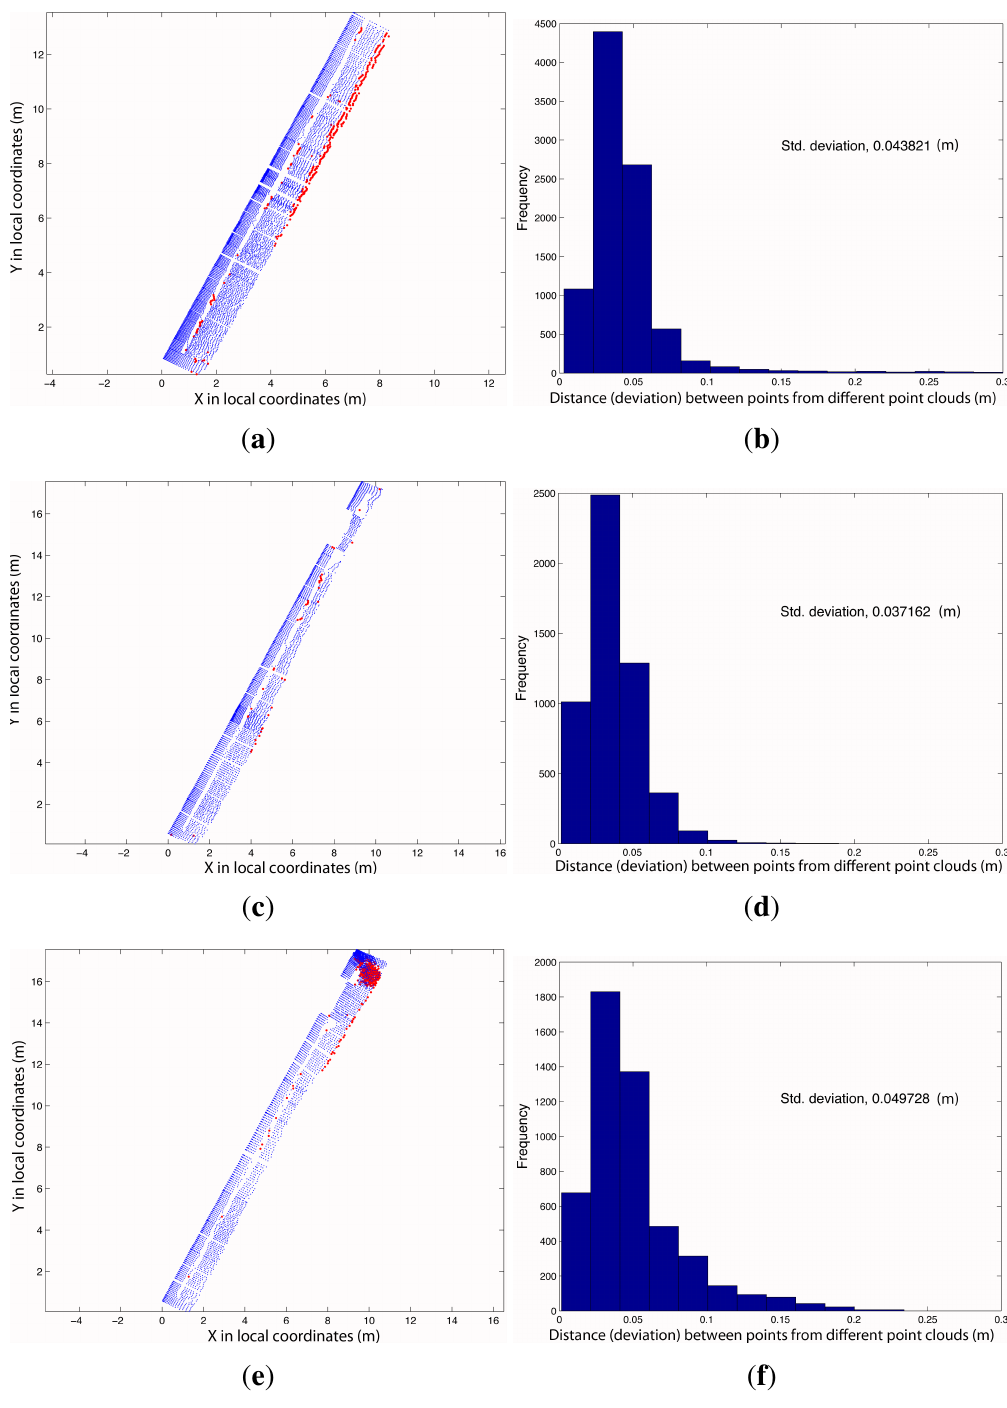
Figure 11. Comparison between four different point clouds produced by four different paths. Red points represent points with errors up to 10 cm. ( a ) Point Cloud 1, where points with errors greater than 0.10 m are represented in red; ( b ) histogram of distances (deviations) between point Clouds 1 and 2; ( c ) point Cloud 3, where points with errors greater than 0.10 m are shown in red; ( d ) histogram of distances (deviations) between point Clouds 3 and 2; ( e ) point Cloud 4, where points with errors greater than 0.10 m are shown in red; ( f ) histogram of distances (deviations) between point Clouds 4 and